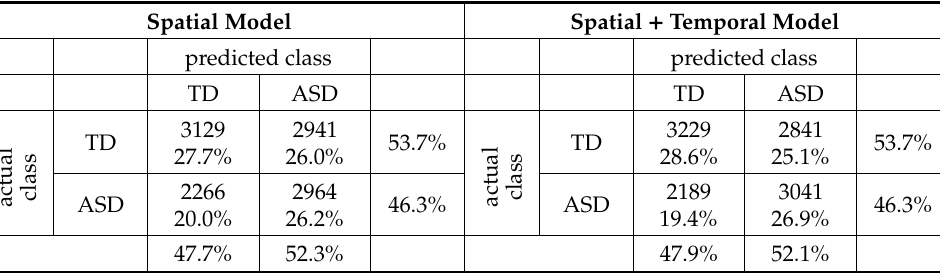
Table 1. The confusion matrices of the spatial model vs. the spatial + temporal model (aggregated across iterations and